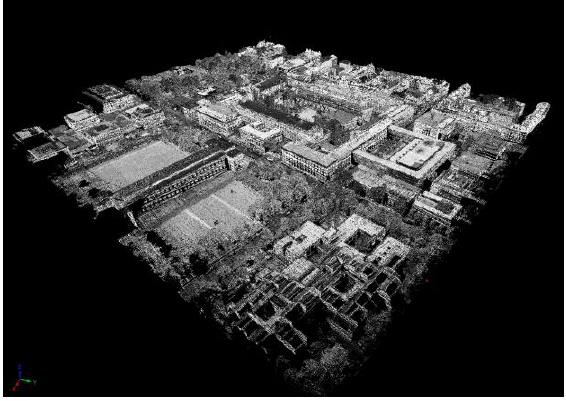
Figure 7. Point cloud with approximately 2.5 million points of TUM area composed of four point clouds from four overflights.